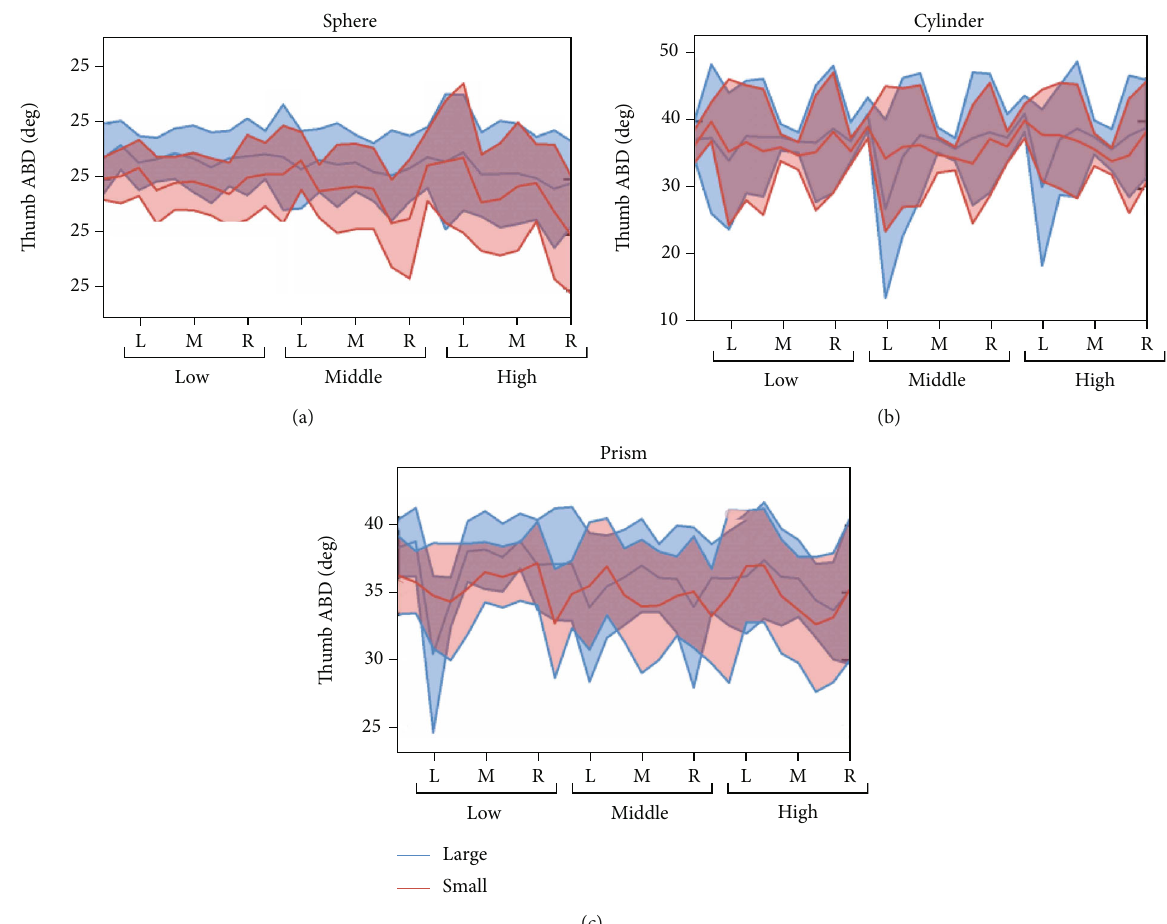
Figure 7: Thumb ABD joint fl exion angle in fl uenced by the object shape, object size, X deviation, Y deviation, and Z